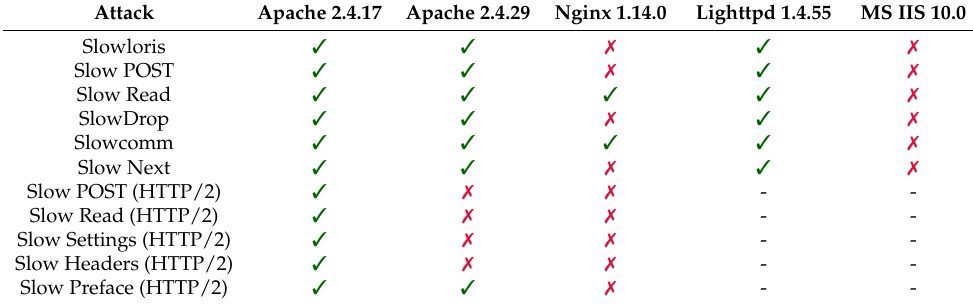
Table 7. Discovered